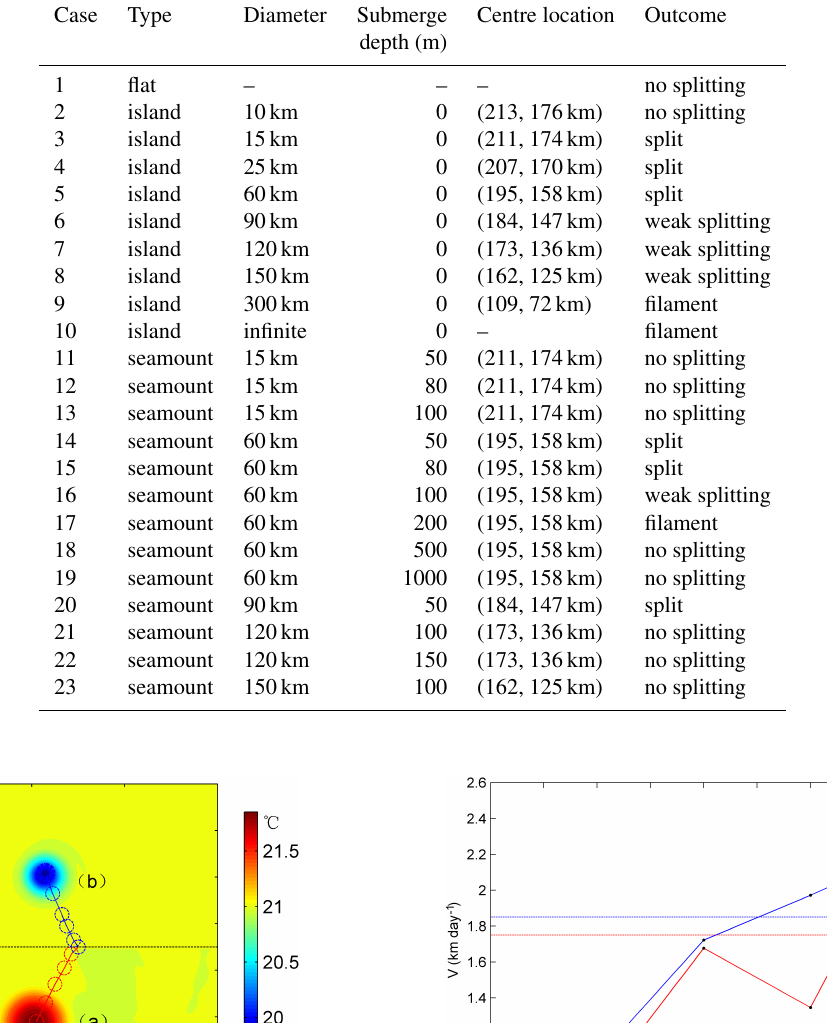
Table 1. List of different topography used in the experiments.